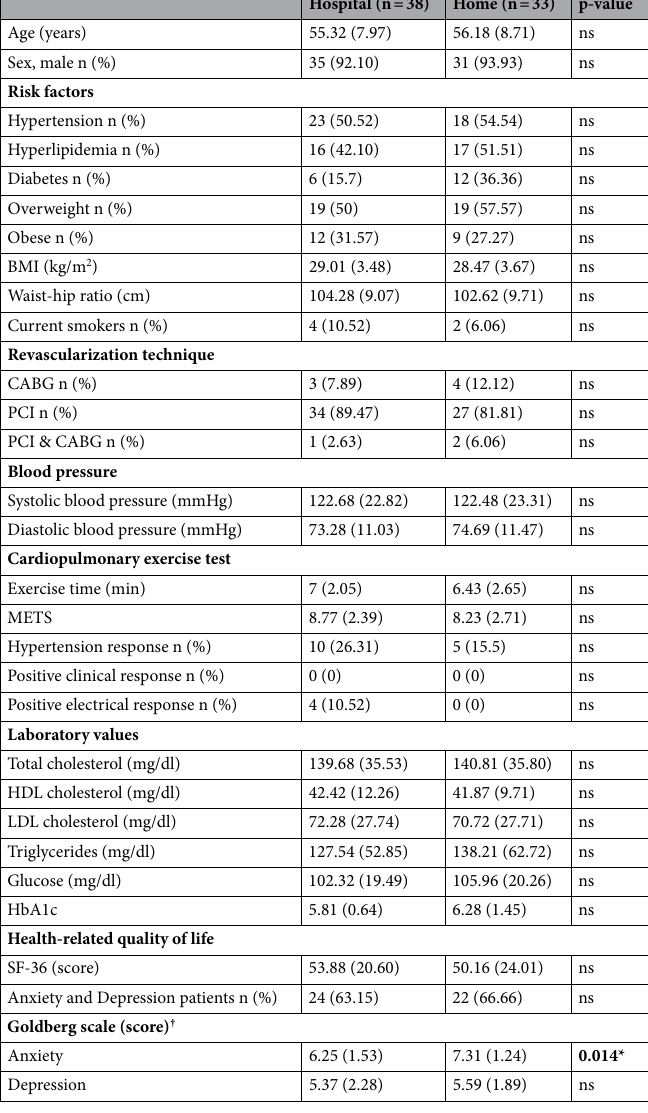
Table 1. Baseline characteristics of the sample. Data are presented as mean values (SD). *Significance level p < 0.05. Significant values are highlighted in bold. † Score of patients with symptoms of depression and